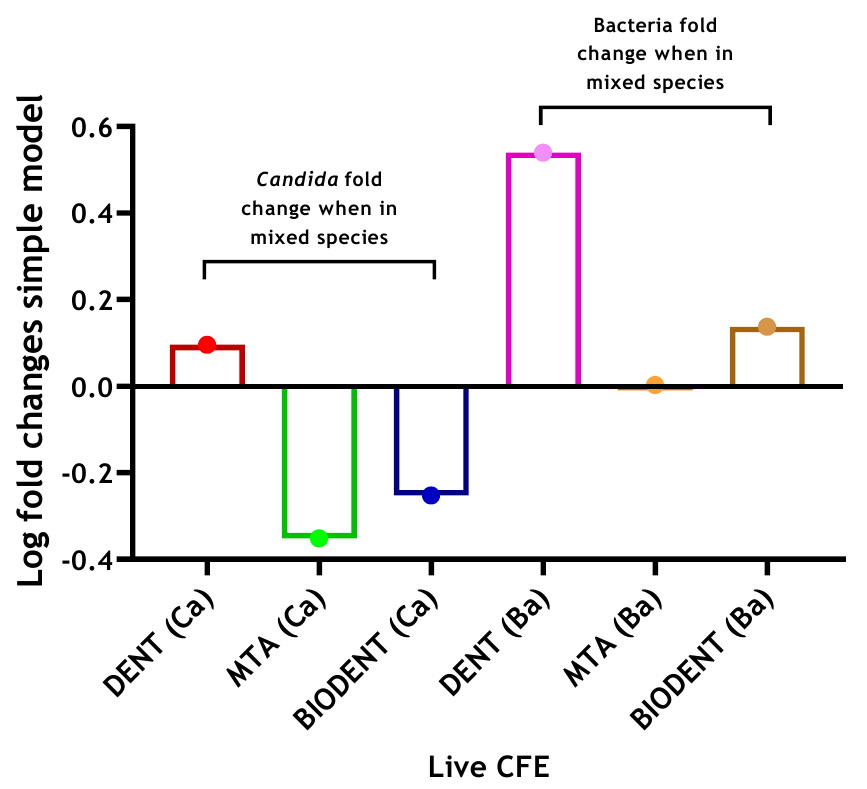
Figure 2. Log fold changes of live yeast and bacteria in complex 4-species biofilm model on three different materials. C. albicans and bacteria were quantified (CFE/mL) in mixed-species biofilms (4 species) and compared to simpler models of C. albicans -only biofilms (1 species) and bacterial-only biofilms (3 species), respectively. Log fold changes were calculated and presented graphically. Data representative from three repeats with 3 technical replicates. Table 1. Percentage composition of mixed-species biofilm model and total and live CFE counts for C. albicans and bacteria in all biofilms following biofilm growth on unaltered MTA, Biodentine and dentine substrates.